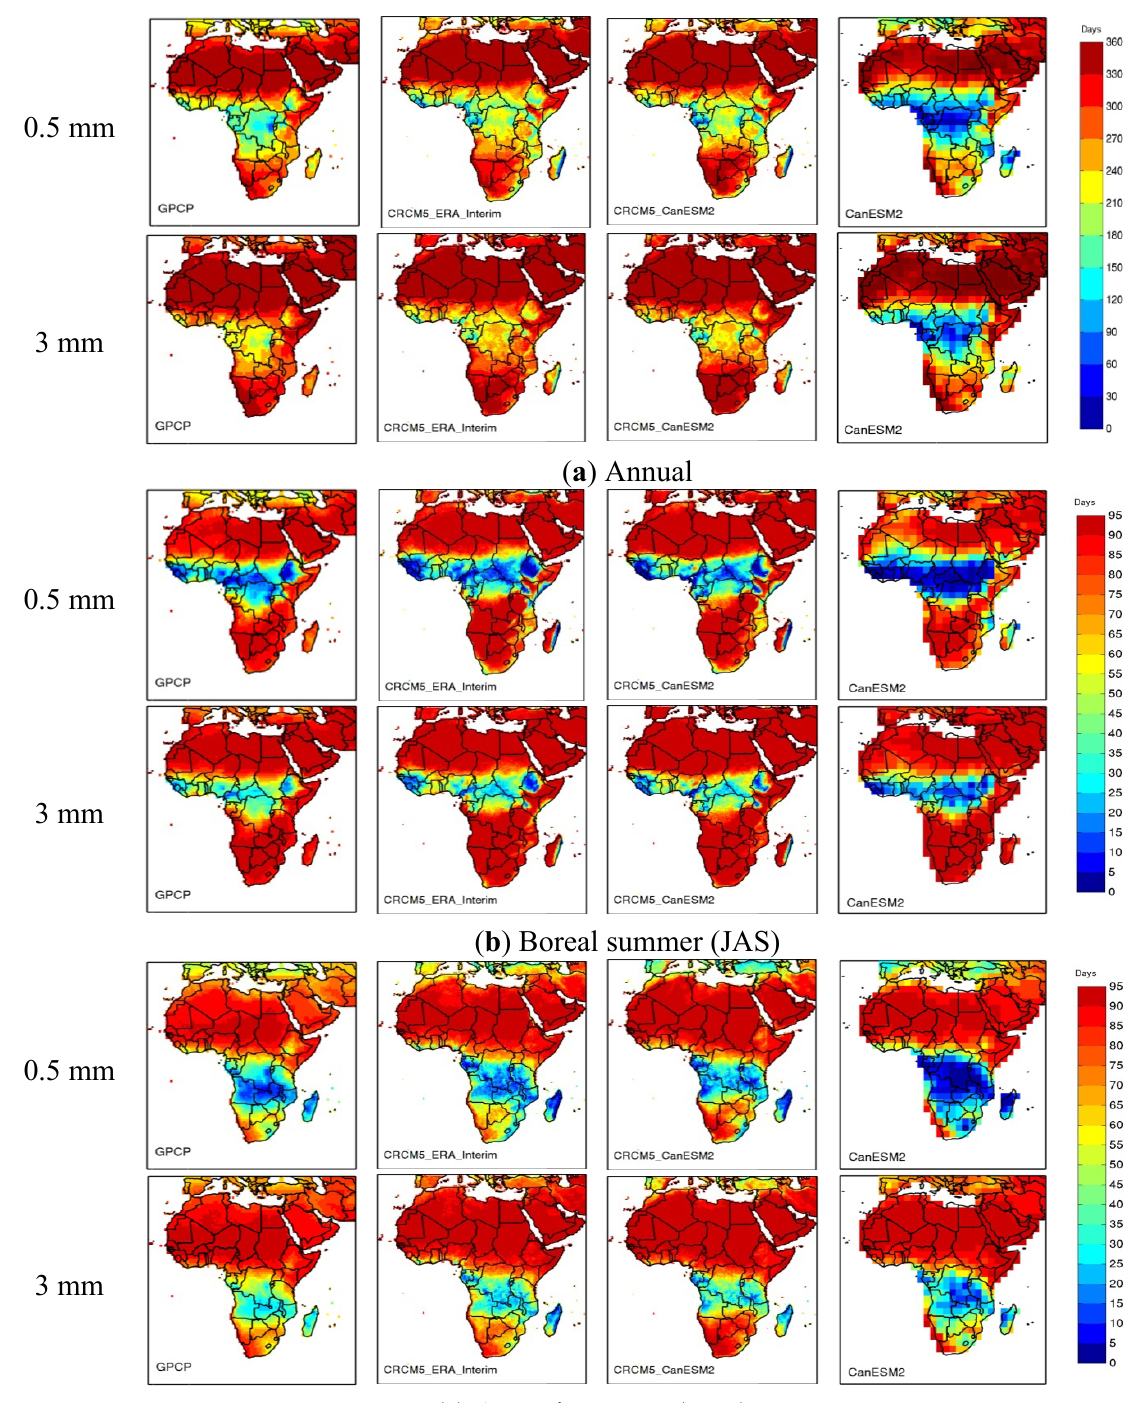
Figure 2. Number of dry days at 0.5 mm (top) and 3 mm (bottom) thresholds for the ( a ) annual, ( b ) boreal summer (JAS) and ( c ) austral summer (JFM) for CRCM5 driven by ERA-Interim (middle left) and CanESM2 (middle right), CanESM2 (extreme right) and GPCP (extreme left), for the 1997–2008